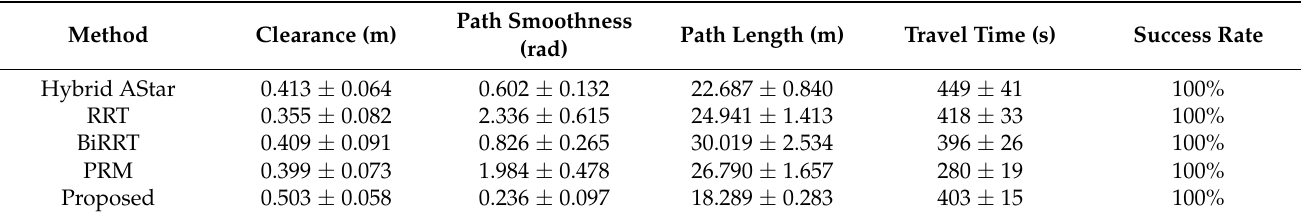
Table 1. Quantitative results for the first